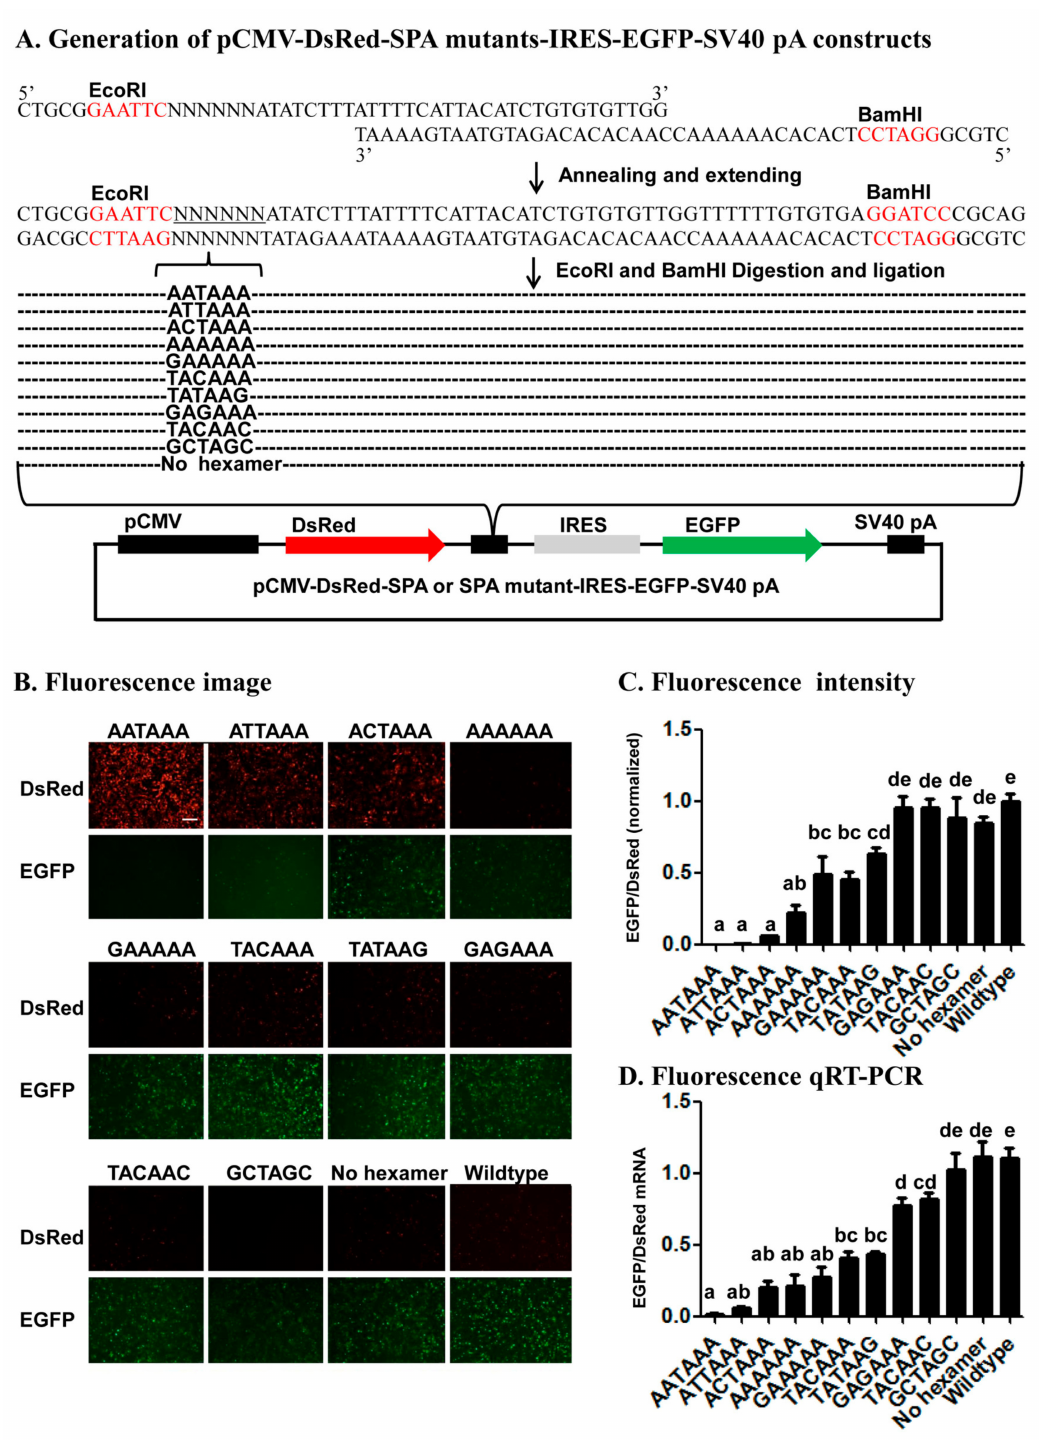
Figure 4. Impact of inserting SPA mutants with different hexamer variants on the relative expression of the two fluorescence reporter genes. ( A ) Generation of pCMV-DsRed-SPA mutants-IRES-EGFP-SV40 pA constructs; ( B ) Fluorescence image. Showed here is a representative HEK293 cell image of 3 independent transfections per construct with a scale bar of 50 µ m; ( C ) Fluorescence intensity; ( D ) Fluorescence qRT-PCR. The data and error bars in ( C , D ) represent the means and standard errors of at least three independent transfections for each wildtype vector or SPA mutant construct. Values sharing the same letter are not significantly different at p < 0.05 (Tukey’s HSD